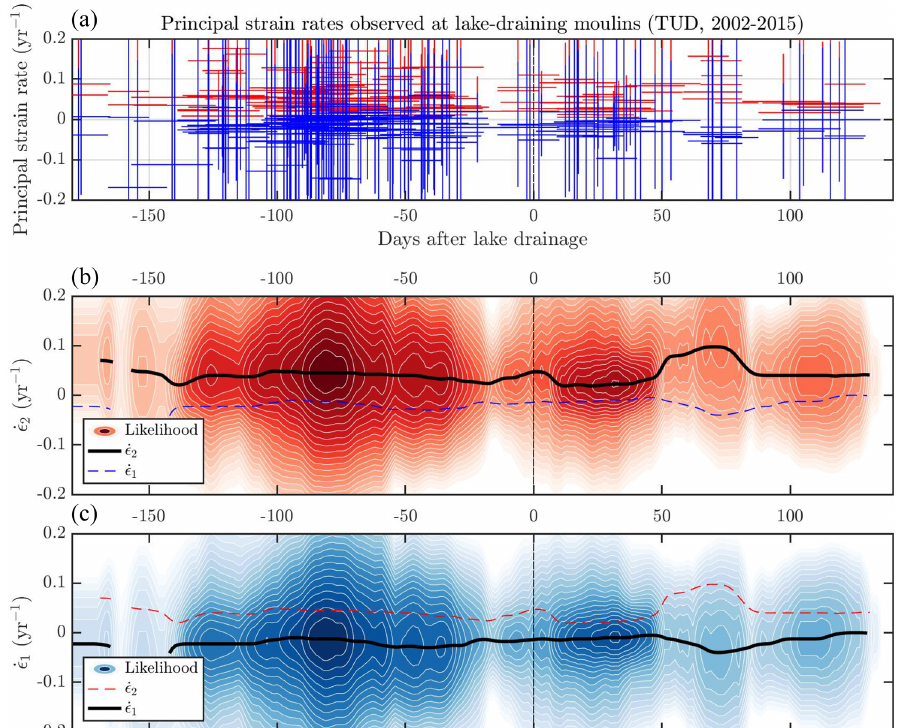
Figure 11. (a) Strain rates at moulins connected to 18 fast-draining lake events over the period 2002–2015 in the Pâkitsoq region below ∼ 900m elevation, calculated from the Landsat-derived velocity product from TUD (Rosenau et al., 2015) with time resolution of 16–32d. Blue lines are more compressional principal strain rates, ˙ (cid:15) 1 , with error bars in strain rate and time; red lines are more extensional principal strain rates, ˙ (cid:15) 2 . (b) The number of observed ˙ (cid:15) 2 displayed as a heat map, with number of observations (colored background) versus strain-rate magnitude ( y axis) and number of days before or after each individual fast-draining lake event ( x axis). Darker colors indicate more likely values of strain rate. (c) The number of observed ˙ (cid:15) 1 displayed as a heat map. These data represent 561 velocity scene pairs, differenced to obtain regional strain-rate observations and interpolated onto 18 moulin sites before, during, and after 97 fast-draining lake events into those moulins over this 14-year period. The black, red, and blue lines plot the time series of the most likely principal strain rates ˙ (cid:15) 1 and ˙ (cid:15) 2 , inferred directly from the data shown in the heat